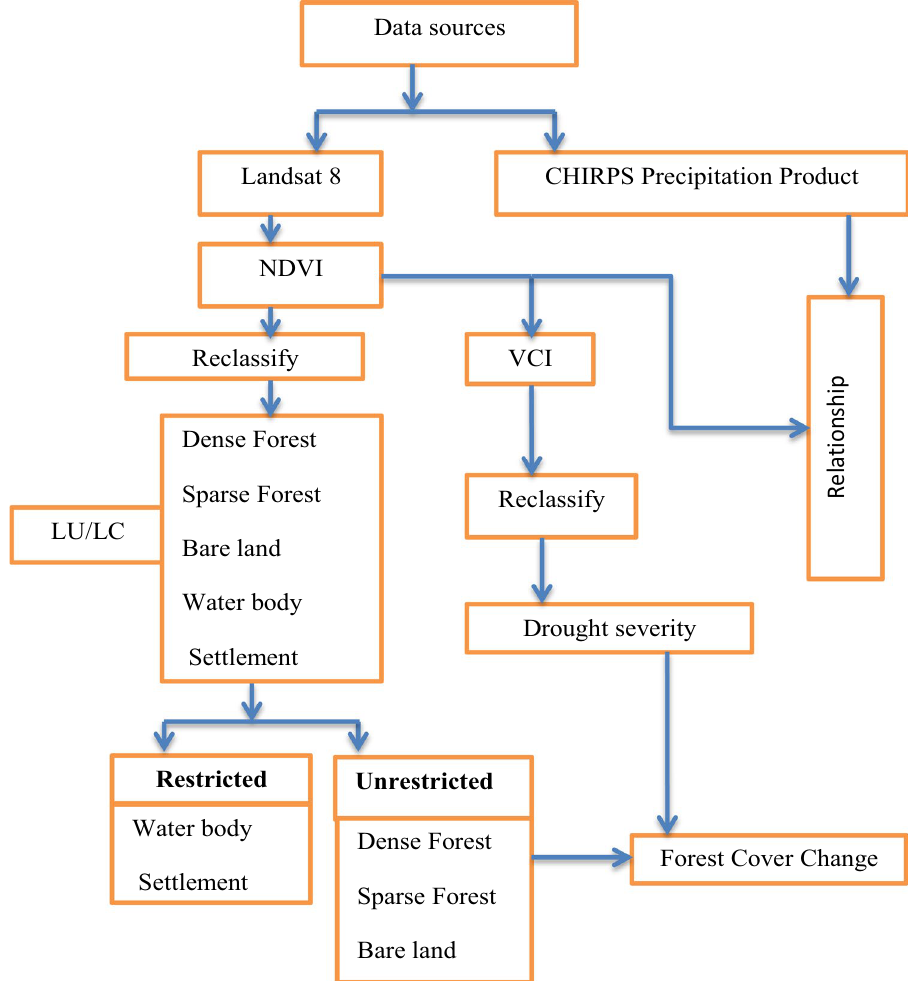
Fig. 2 Methodological flow- chart of the